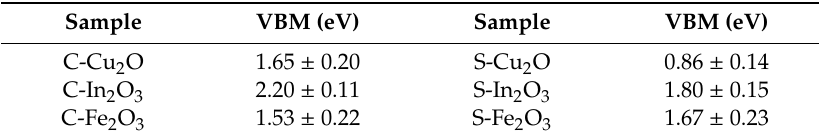
Table 3. Valence Band Maxima extracted from XPS measurements. The error values were determined from the regression method extrapolation.